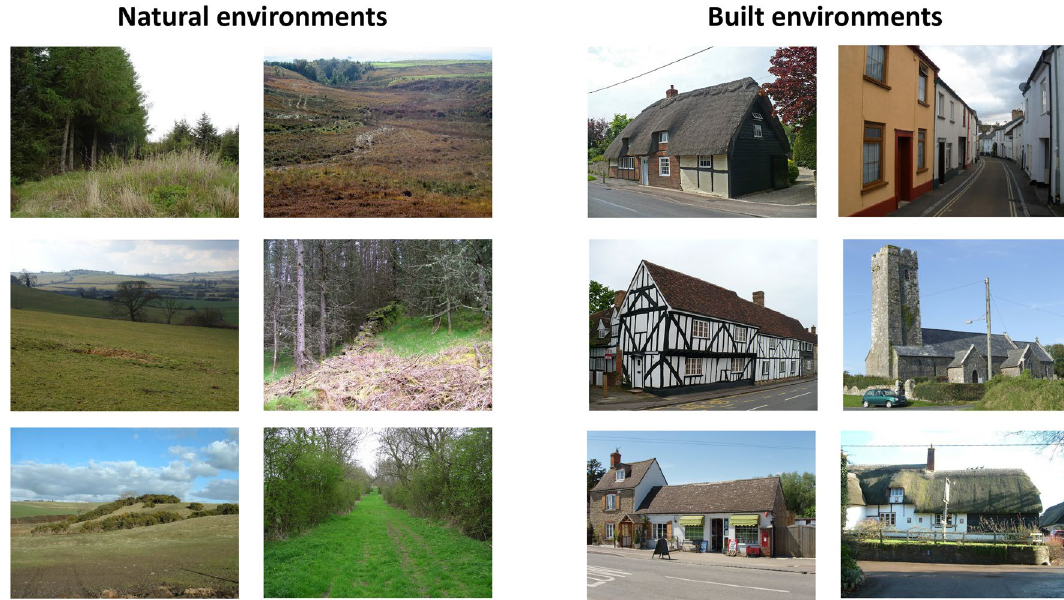
Figure 1. Example stimuli from the natural vs. built environment condition (photos taken from the website http://www.Geogr aphy.org.uk/). From left to right, top to bottom in each row: “Clocaenog forest” by Dot Potter CC, https ://www.geogr aph.org.uk/photo /17700 9. “Hillside at Ashendon” by Andrew Smith CC. https ://www. geogr aph.org.uk/photo /13656 4. “Gorse & Farmland near Endmoor” by David Medcalf CC. https